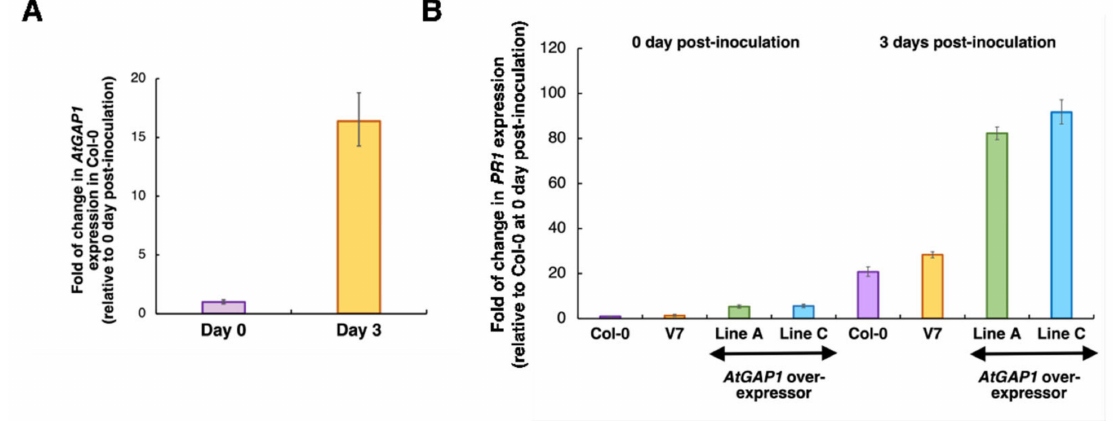
Figure 1. AtGAP1 is inducible in Arabidopsis by pathogen ( Pst DC3000) inoculation and AtGAP1 - overexpressors are more effective in activating the pathogen-resistance marker gene, PR1 , than wild type or the empty vector control. The rosette leaves of five-week-old wild type Arabidopsis (Col-0), empty vector control (V7), and AtGAP1 -overexpressors (independent lines A and C) were inoculated with Pst DC3000. Total RNA was extracted from the aerial part of the plants. ( A ) AtGAP1 expression was induced in Col-0 at 3 days post-inoculation (Day 3) with Pst DC3000, compared to Day 0. ( B ) The relative expressions of PR1 in wild type (Col-0), V7 (empty vector control), and AtGAP1 -overexpressors (lines A and C) at 0 and 3 d post-inoculation (dpi). Gene expression levels were normalized to 0 dpi levels of Col-0, using ACT7 (AT5G09810) as the reference gene [54], by the 2 − ∆∆ Ct method [55]. Three plants of each line were pooled as one sample for total RNA extraction and expression analysis. For each sample, three technical repeats of the RT-qPCR were performed. Error bars represent the standard errors of the three technical repeats. A similar expression trend was observed in another biological repeat (Figures S3 and